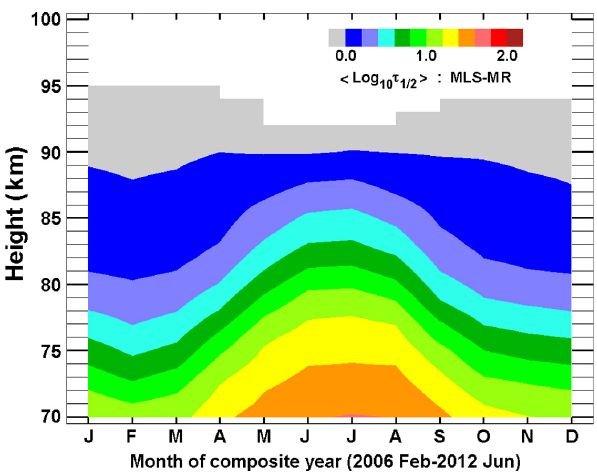
Fig. 9. Composite year, monthly mean difference between measured and MLS log 10 τ 1 / 2 . This is effectively log 10 (MLS D a /MR D a ).